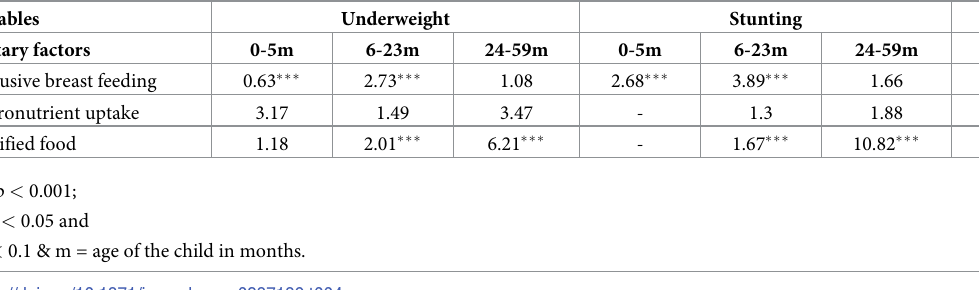
Table 4. Dietary factors affecting nutrition outcome by rural children ages ranging from 0–5, 6–23 and 24–59